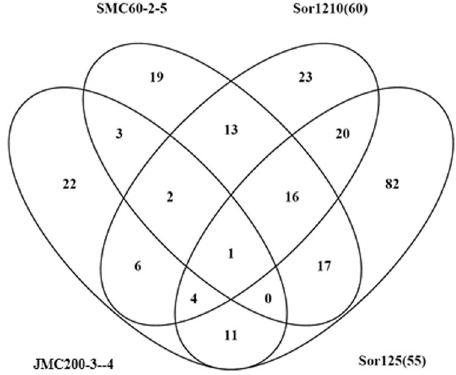
Figure 3. Venn diagrams showing genes that were expressed at disomic level on the monosomic Ch5 in all four mutants JMC200-3-4, SMC60-2-5, Sor1210(60), and Sor125(55). Numbers in intersections of the circles represent the number of shared genes, while the number in the larger part of the circle represents the genes unique to that particular mutant.